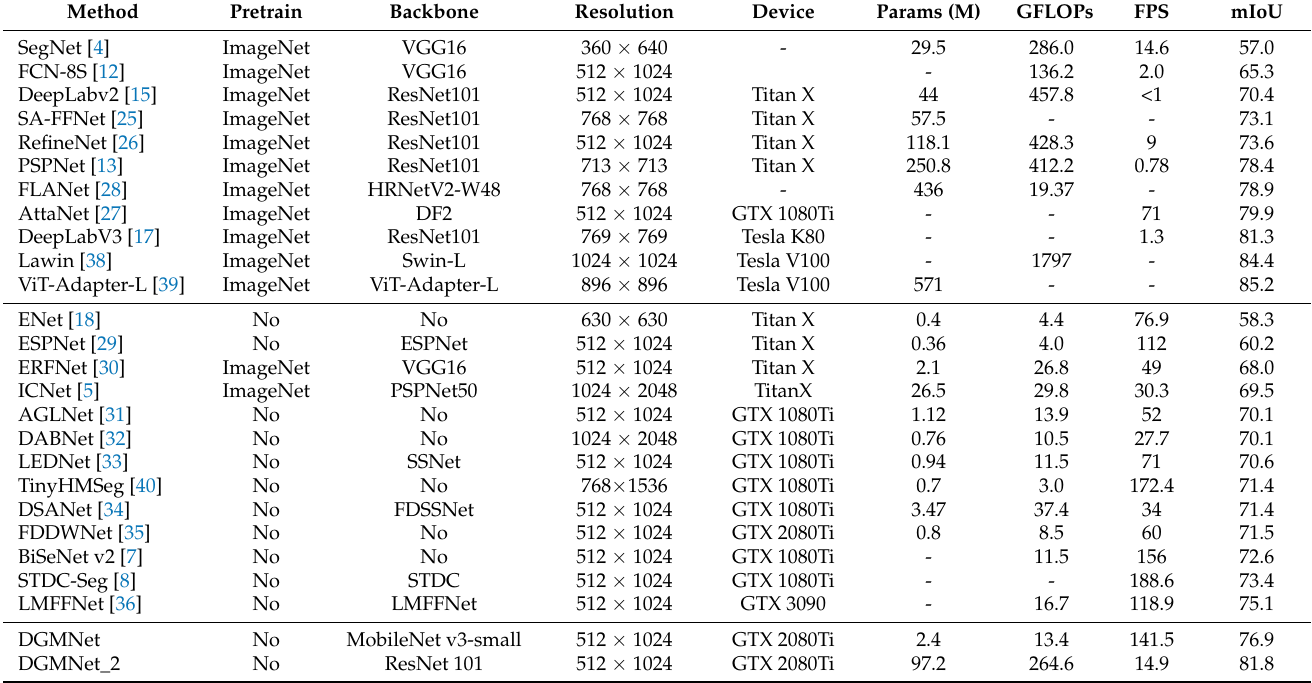
Table 4. Comparison of our method and other state-of-the-art methods on the Cityscapes test